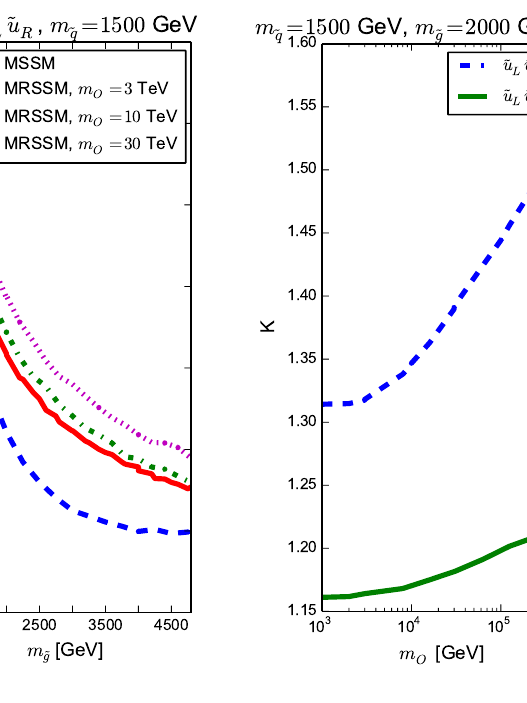
Figure 9. Dependence of the K-factor on the sgluon mass for ~ q ~ q and ~ q ~ q y production in the